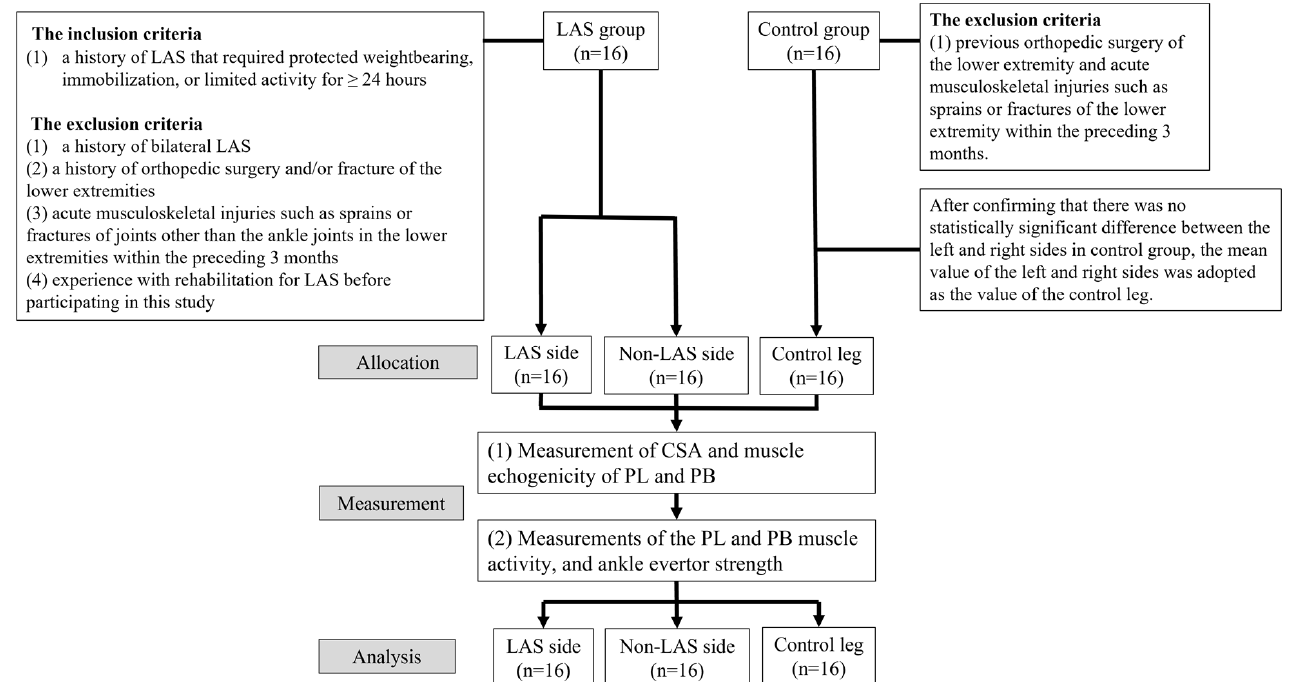
Figure 1. Flowchart of the methodology of this study.